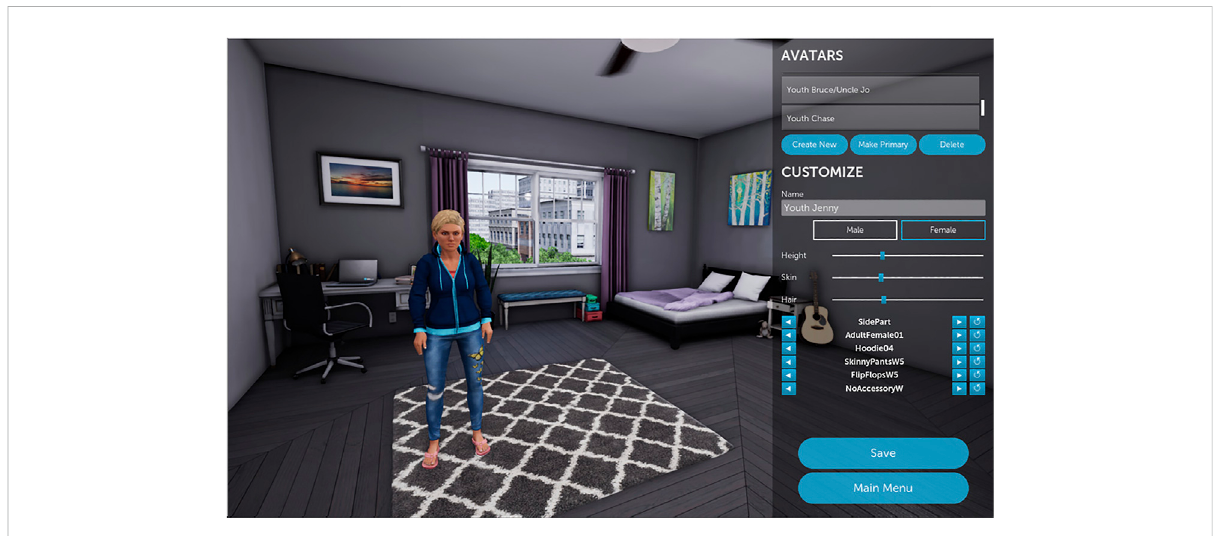
FIGURE 1 Charisma 1.0 avatar creator. Participants have the option to customize their avatar within the virtual world to create a sense of